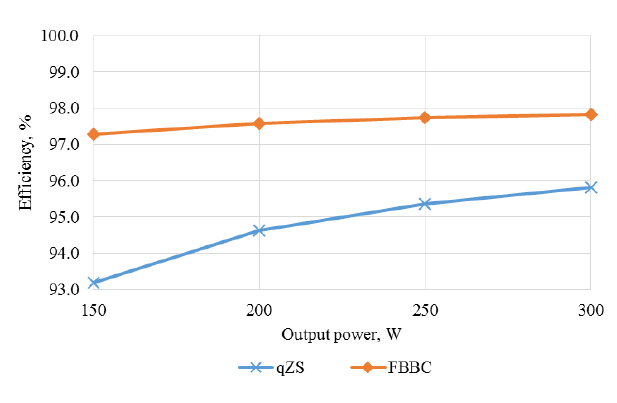
Fig. 9. Efficiency of qZS and IFBB converters versus output